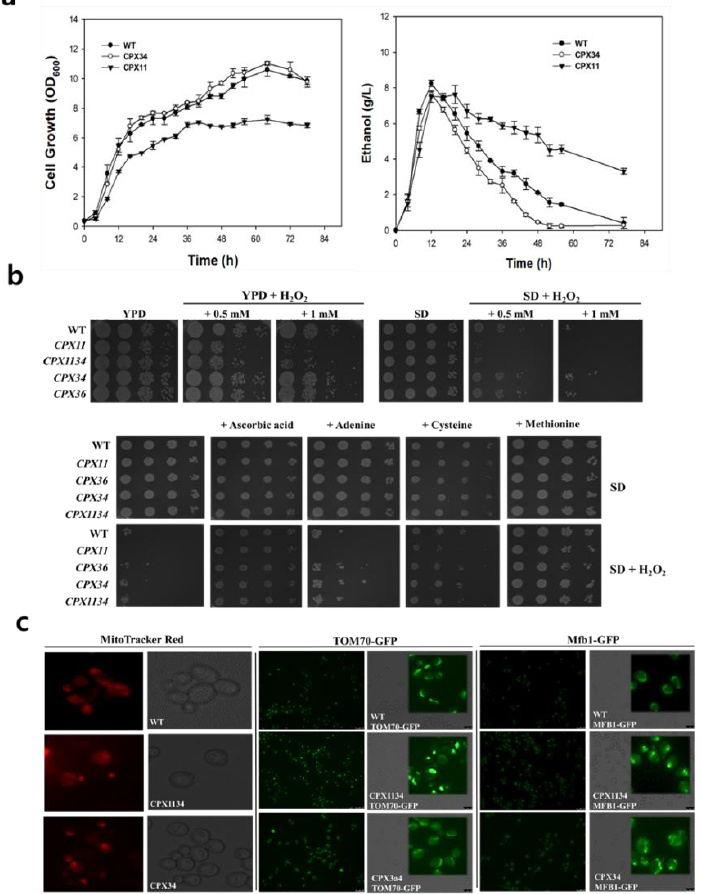
Figure 2. Sensitivity of peroxisome-engineered strains to oxidative stress. ( a ) Cell growth ( left ) and ethanol consumption ( right ) of wild-type (WT), CPX11, and CPX34 in YPD medium. Data are presented as the mean ± standard deviation of biological triplicates. ( b ) Growth of peroxisome-engineered strains (WT, CPX11, CPX34, CPX36, and CPX1134) on YPD and synthetic defined agar plates with and without 0.5 mM and 1 mM H 2 O 2 supplementation (upper) and growth on synthetic defined agar plates with and without 1 mM H 2 O 2 supplementation and cellular oxidative stress sup- pressors (ascorbic acid, adenine, cysteine, and methionine). ( c ) Fluorescent microscopy analysis of the mitochondrial morphology of WT, CPX34, and CPX1134. Fluorescence was monitored using fusion proteins of the mitochondrial proteins TOM70 and Mfb1 linked with enhanced green fluorescent protein and MitoTracker Red.